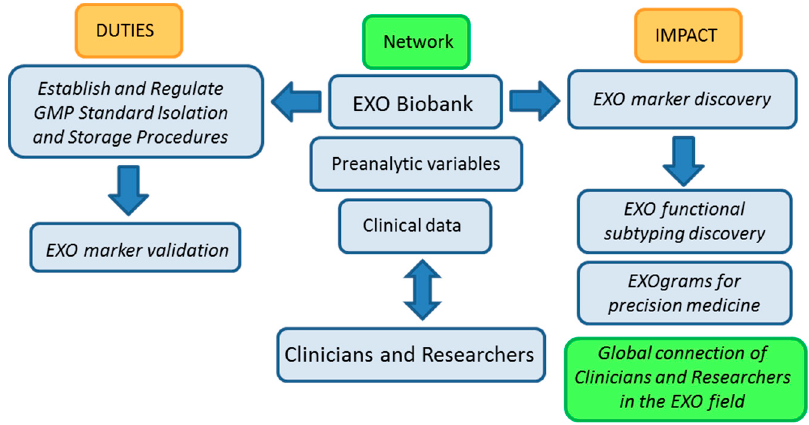
Figure 2. Biobanking of EXOs (exosomes) workflow: duties and impact on the advance of EXO-based research. GMP (Good Manufacturing Practices). research. GMP (Good Manufacturing